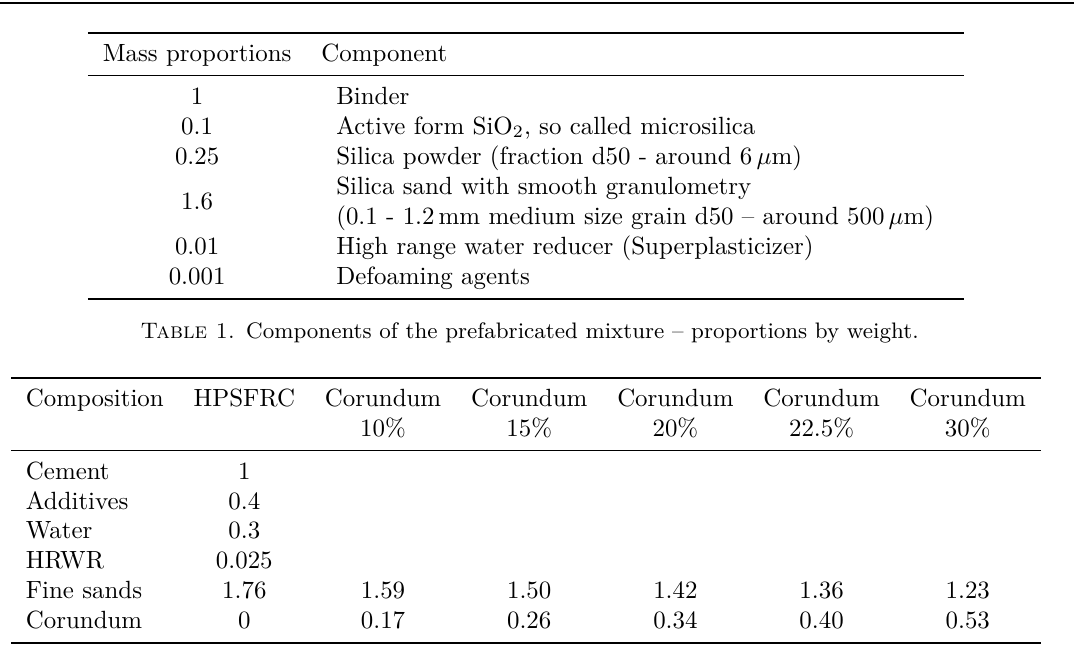
Table 2. Composition of high-performance concrete with corundum.